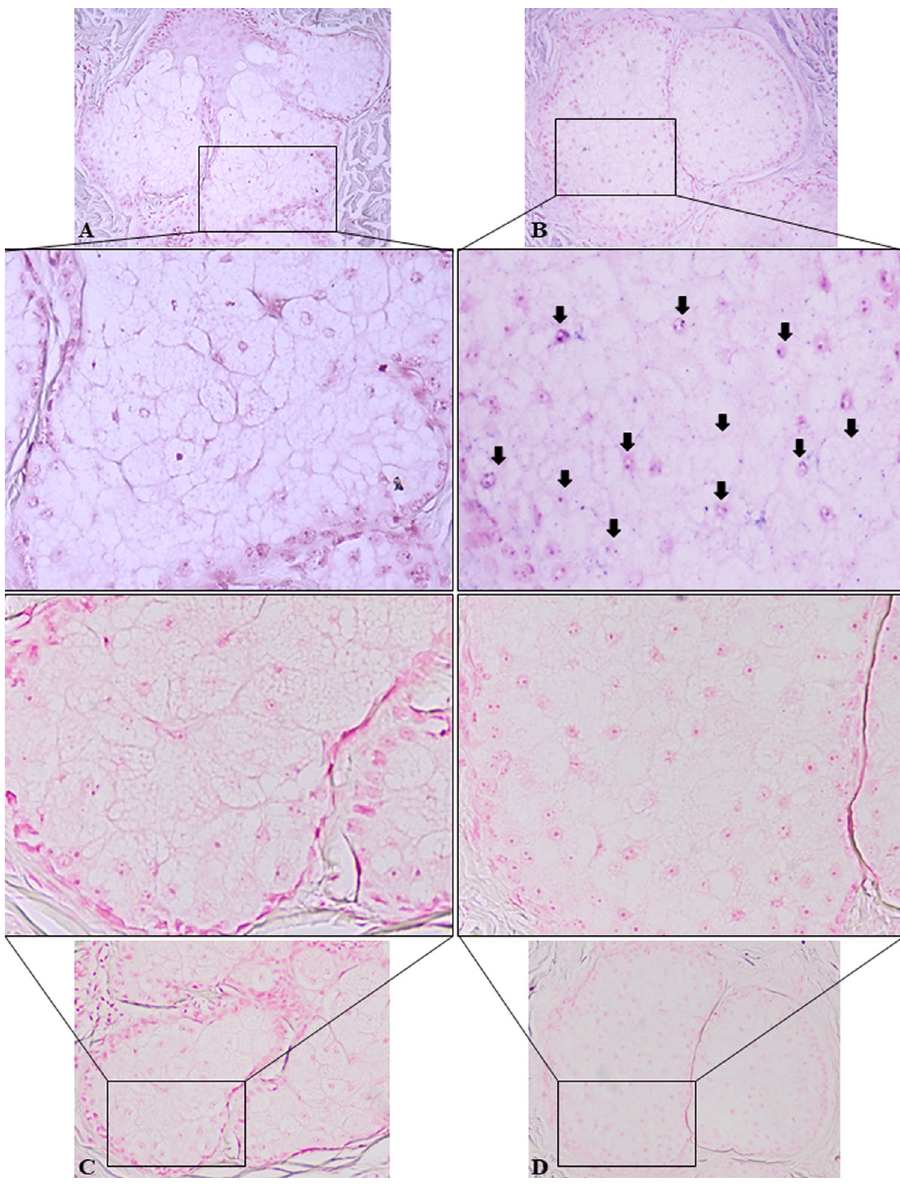
Figure 2. In situ detection of miR-146a on FFPE tissue samples. Compared with normal skin samples ( A ), a more intense, granular blue hybridization signal was detected in sebaceous glands of acne vulgaris samples ( B ). Negative control staining of normal ( C ) and acne vulgaris ( D ) skin samples as described in “Methods”. Samples obtained from the back of patients. Arrows show miR-146a positive sebocytes. Chromogenic in situ hybridization, NBT/BCIP blue chromogen with nuclear Fast Red background staining. Original magnification × 200, Representative microphotograph, n =